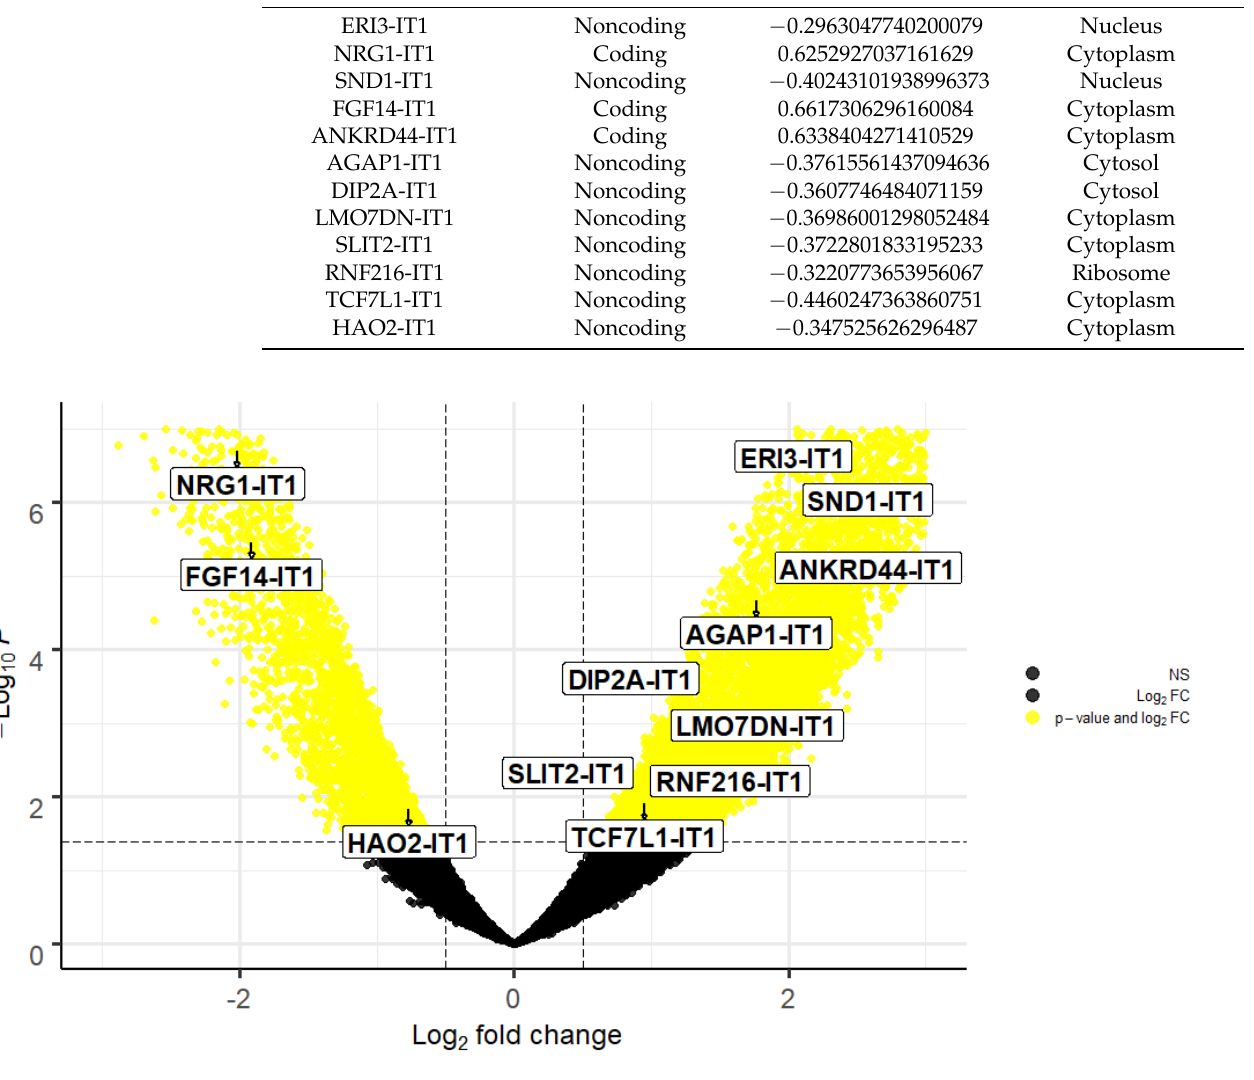
Figure 1. Volcano plot of the distributions of differentially expressed genes and transcripts. The yellow dots indicate the differentially expressed genes and transcripts (adjusted p < 0.05) between osteosarcoma tumour versus normal bone samples. The block dots represent not significant differentially expressed genes ad transcripts. The vertical and horizontal dotted lines highlight the cut-off value of Log2 fold-change = ±0.5, and of p -value (−Log 10 p) = 0.05, respectively. The plot indicates that NRG1-IT1, FGF-IT1 and HAO2-IT1 were downregulated in osteosarcoma tumour samples compared to normal, whereas ERI3-IT1, SND1-IT1, ANKRD44-IT1, AGAP1-IT1, DIP2A-IT1, LMO7DN-IT1, SLIT2-IT1, RNF216-IT1, and TCF7L1-IT1 were upregulated in tumour samples. The volcano plot was generated using R studio software (version 4.1.0).